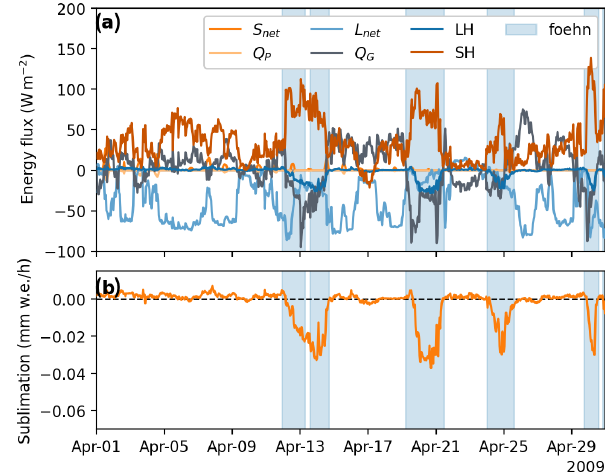
Figure 7. (a) Energy balance components and (b) simulated sub- limation during April 2009. Background shading indicates periods that are flagged as